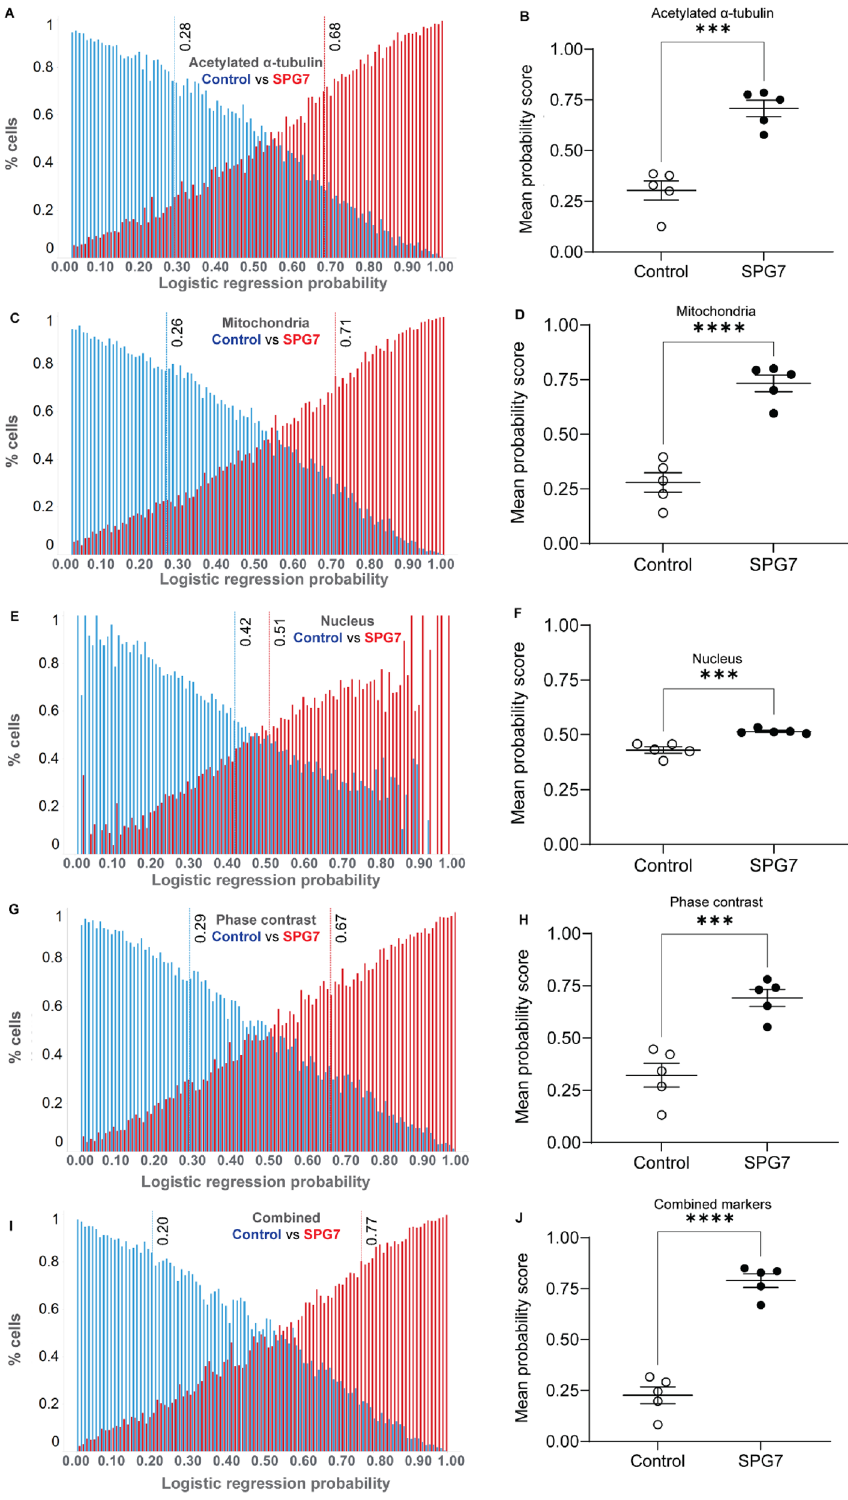
Figure 4. Logistic regression analysis of SPG7 patient vs control samples. Histogram of single cell logistic regression probability scores is presented for 32,268 cells from 5 SPG7 patient and 5 control individuals for multiple cell components: acetylated α-tubulin ( A ), mitochondria ( C ), nucleus ( E ), cell phase contrast ( G ) and combined markers ( I ). Dotted lines indicate mean probability score values. The mean logistic regression probability score showing all the individual patient and control cell lines is presented for acetylated α-tubulin ( B ), mitochondria ( D ), nucleus ( F ), the cell phase contrast image ( H ) and combined markers ( J ). Mean values were compared using students